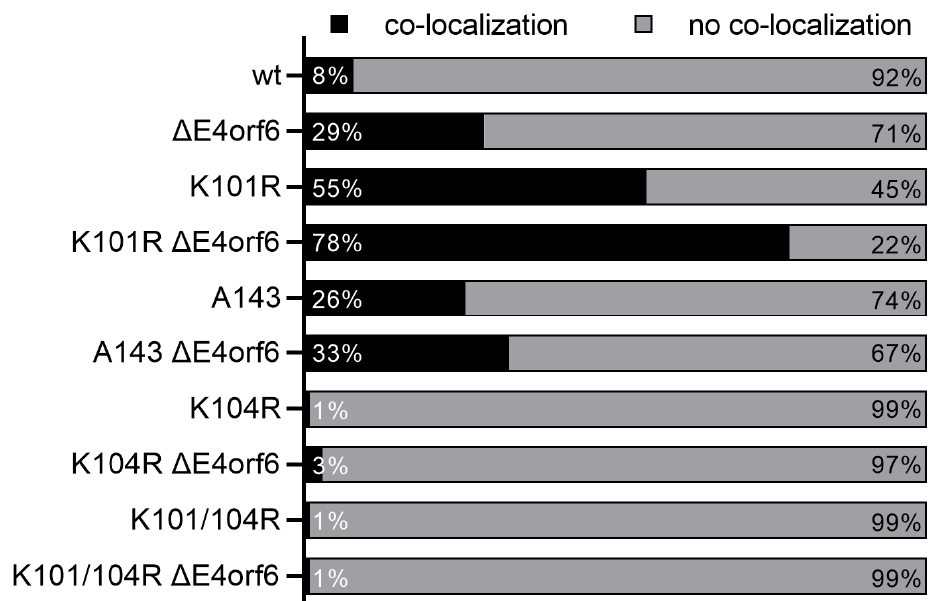
Figure 5. E4orf6 modulates the co-localization of E1B-55K and SUMO2 in viral RCs. Quantifications of E1B-55K and SUMO 2 co-localizations in A549 cells (Figure S2). For each virus infection, approxi- mately 300 infected cells were analyzed and the number of cells in which both proteins co-localize was determined. The respective numbers are indicated in percentages.